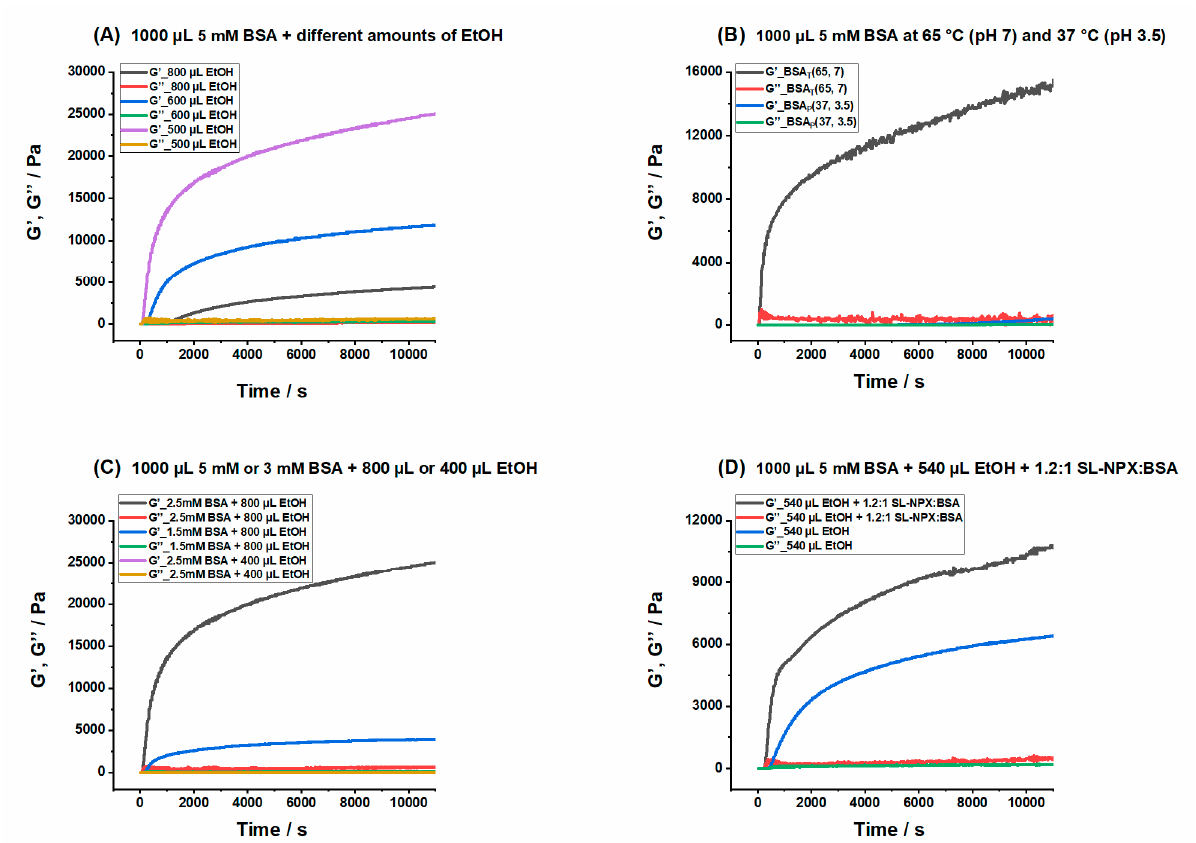
Figure 2. Time-dependent elastic (G ′ ) and viscous moduli (G ″ ) of ( A ) 1000 µL 2.5 mM BSA E (37, 7) with different amounts of ethanol, ( B ) 1000 µL 2.5 mM BSA T (65, 7) and BSA P (37, 3.5), ( C ) 1000 µL 2.5 mM or 1.5 mM BSA E (37, 7) with 800 µL or 400 µL ethanol and ( D ) 1000 µL 2.5 mM BSA E (37, 7) with 540 µL ethanol in the presence and absence of SL-NPX. Total volume of each sample is 2000 µL, which is reached by adding appropriate amounts of water to the mixture of BSA, ethanol, and SL-NPX to reach the desired final volume.